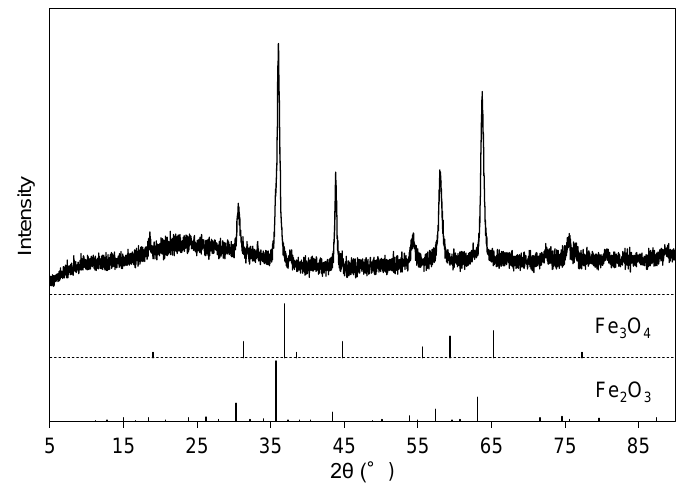
Figure 5. XRD pattern of Precipitate B after heat treatment at 700 °C for 1 h.